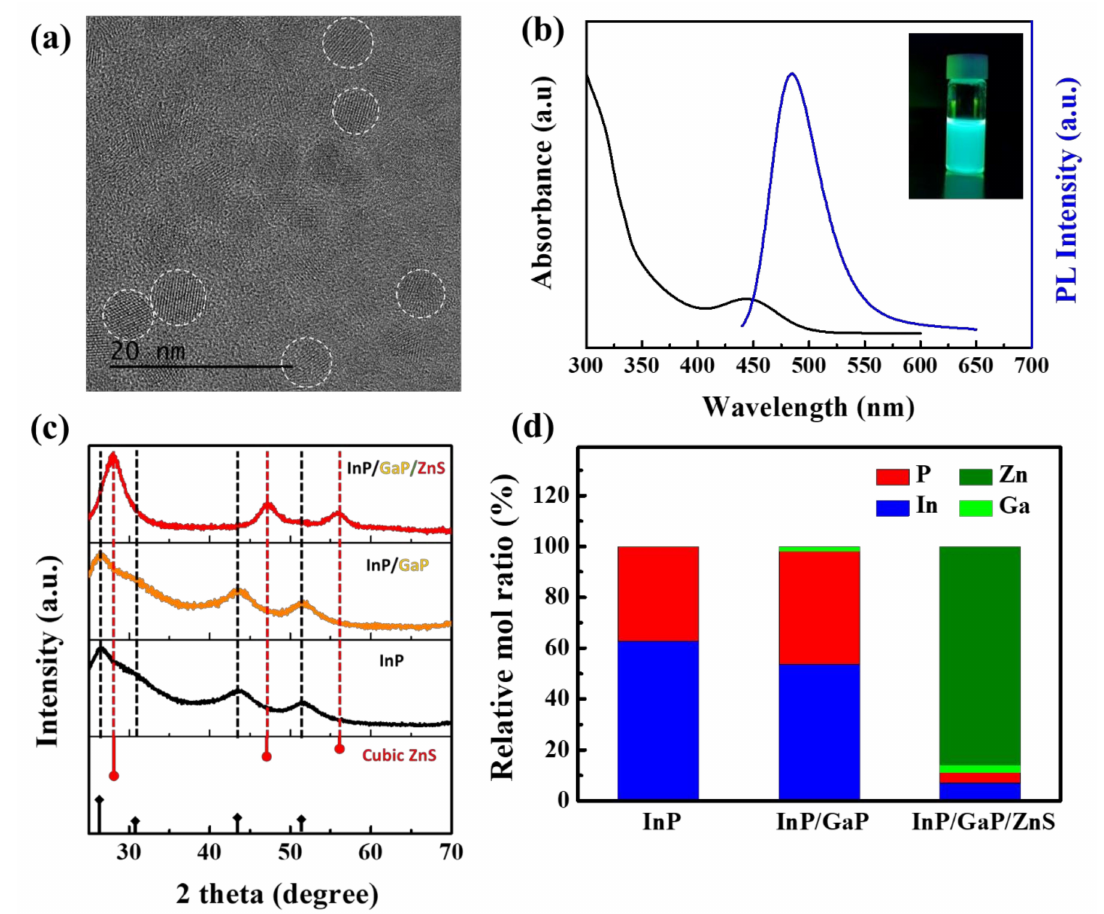
Figure 5. ( a ) TEM images and ( b ) normalized PL and absorption spectrum of the blue-emissive InP / Ga / ZnS QDs. ( c ) XRD pattern (the corresponding bulk reflections of the cubic zinc blende InP and cubic ZnS are shown in the lower panels) and ( d ) relative molar ratios of InP, InP / GaP, and InP / GaP / ZnS QDs analyzed by